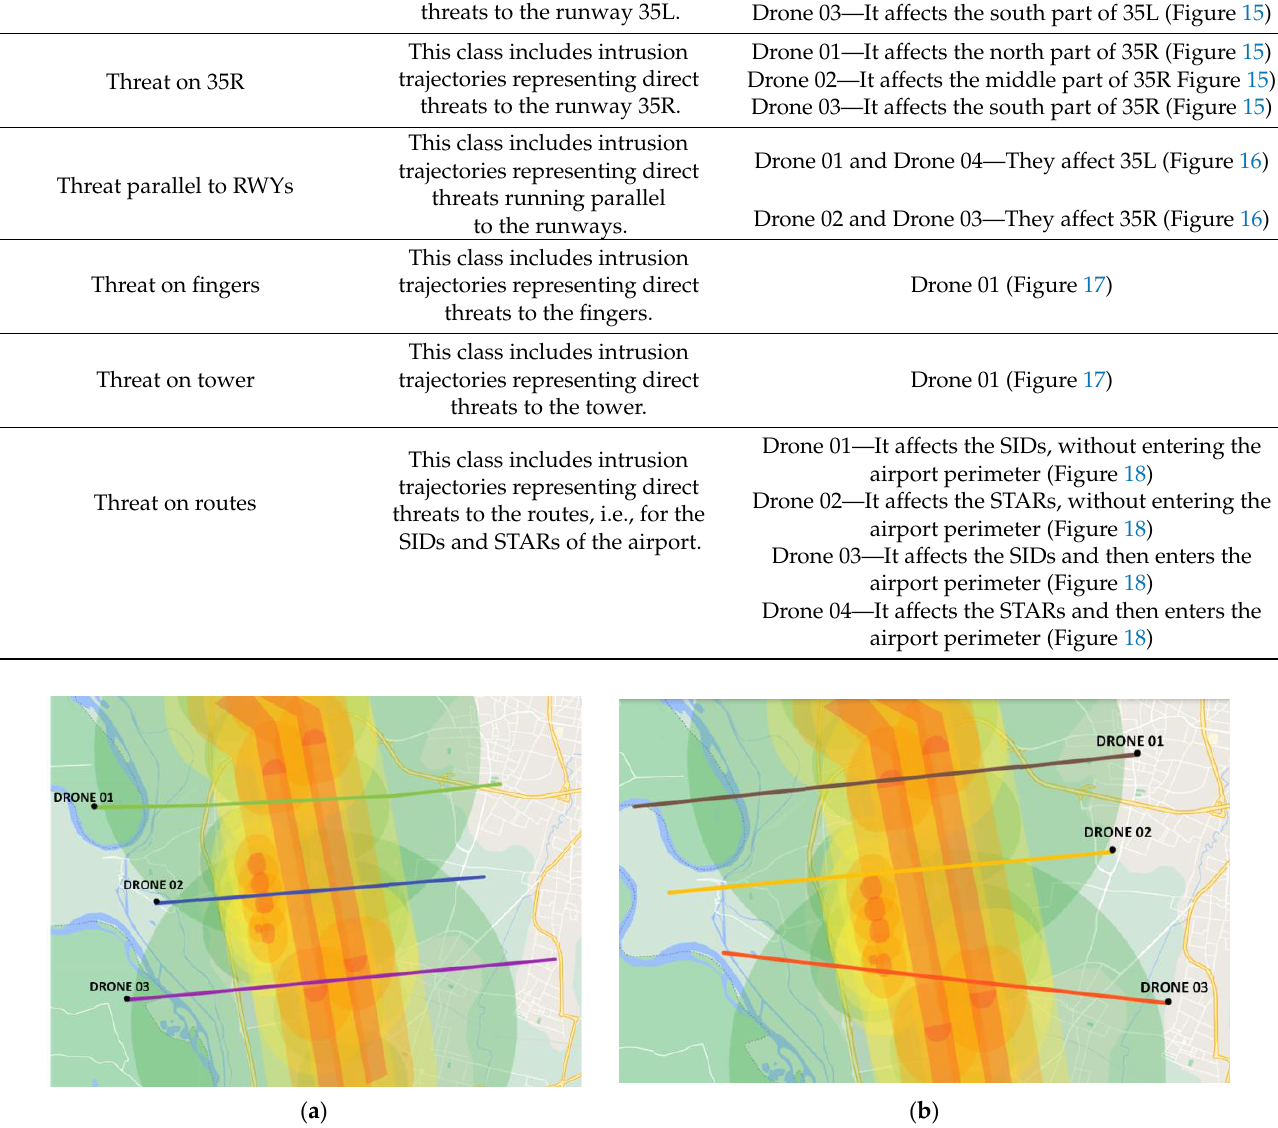
Figure 15. Instances of threat scenario classes. ( a ) “Threat on 35L”. ( b ) “Threat on 35R”.